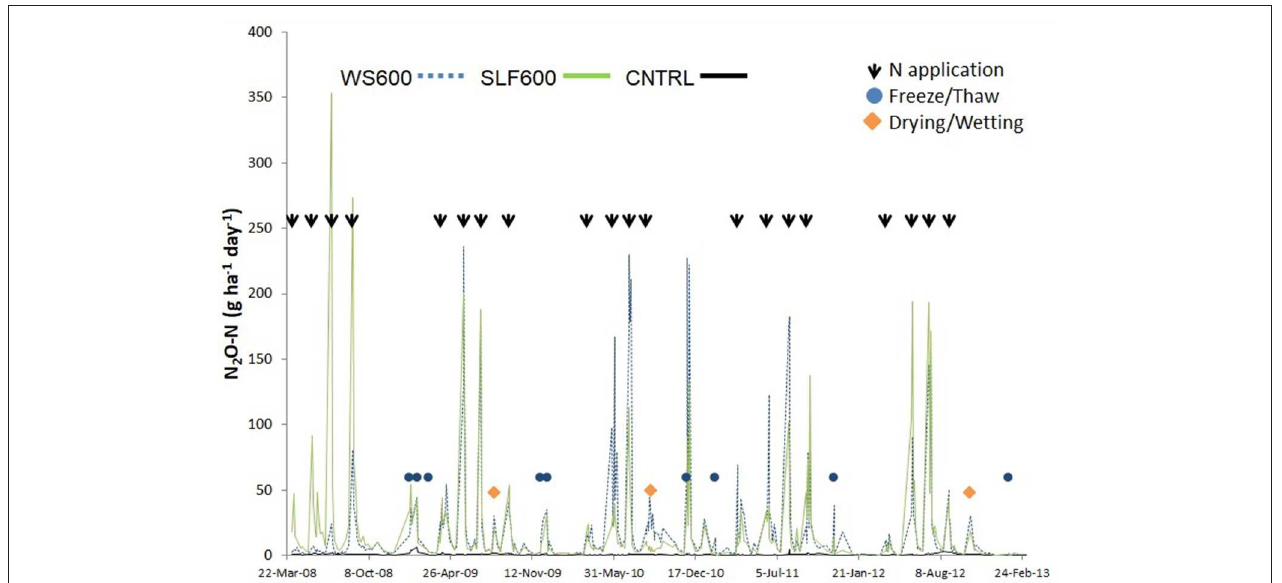
FIGURE 2 | Daily nitrous oxide (N 2 O-N) emissions measured between 10 April 2008 and 6 March 2013 ( ∼ 59 months) on replicated perennial grass plots treated with whole and separated slurry (WS600 and SLF600, respectively) applied nominally at 600kg N ha − 1 yr − 1 , in four equal doses. Day of manure applications and of freeze/thaw and dry/wet cycles are